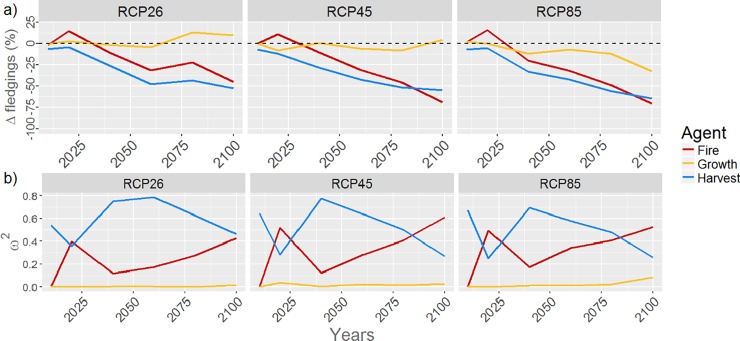
Trends in a) the relative difference of potential productivity (ΔProd) between the reduced and the full model for each driver of change and in b) ω2 for each driver of change in Black-backed Woodpecker potential productivity under the RCP 2.6, RCP 4.5 and RCP 8.5 forcing scenarios. In b), ω2 values were obtained through three-way factorial ANOVA performed at each time step.